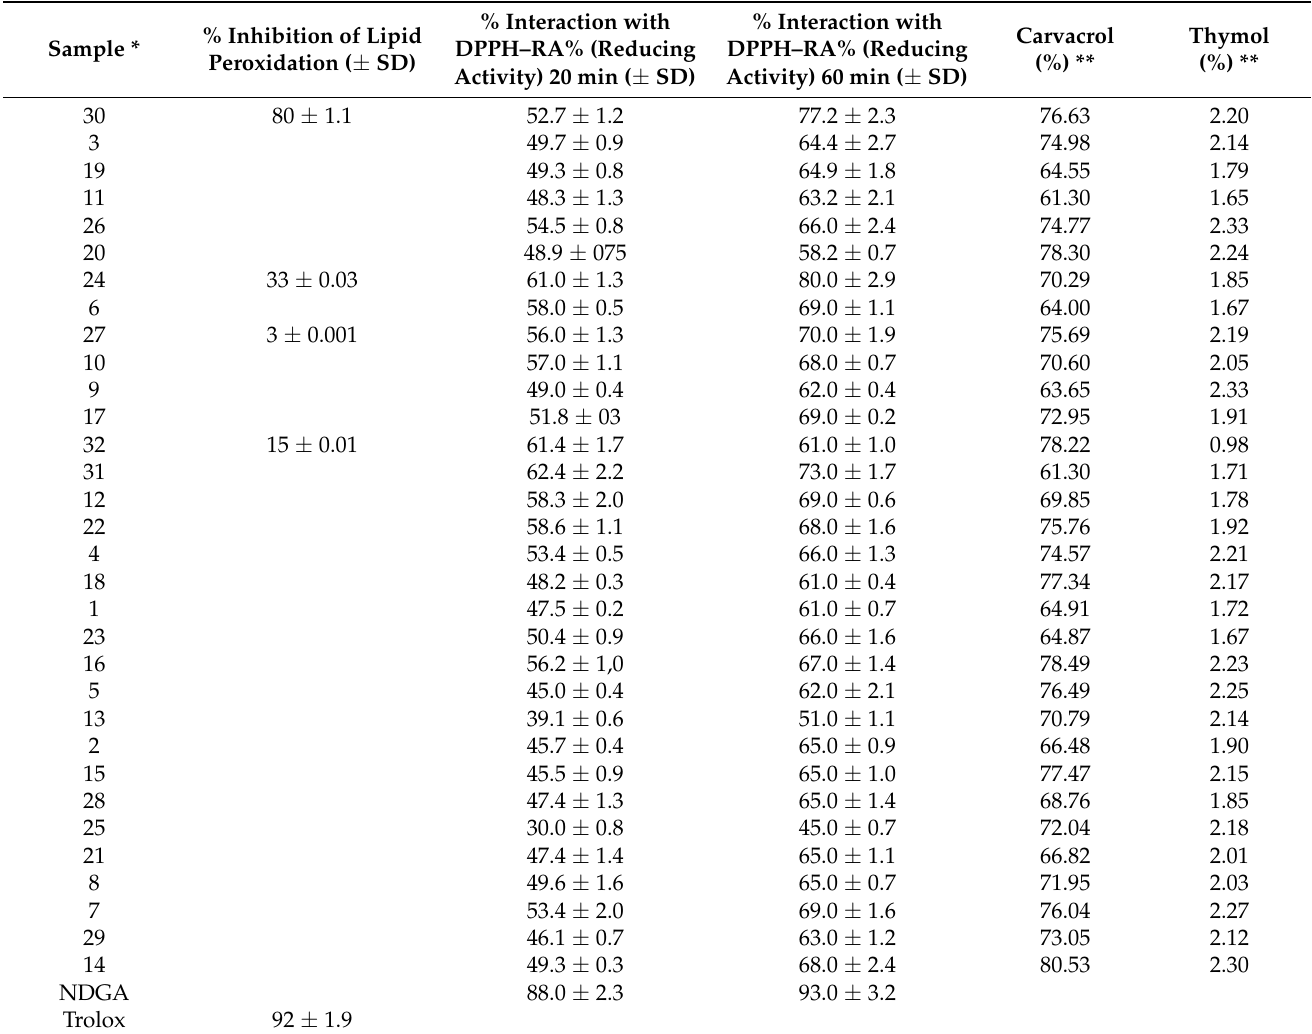
Table 4. In vitro antioxidant activity, as % reducing activity values (RA%) and % inhibition of lipid peroxidation values, for the 32 essential oils in correlation with the abundance of oregano’s main phenolic monoterpenes.